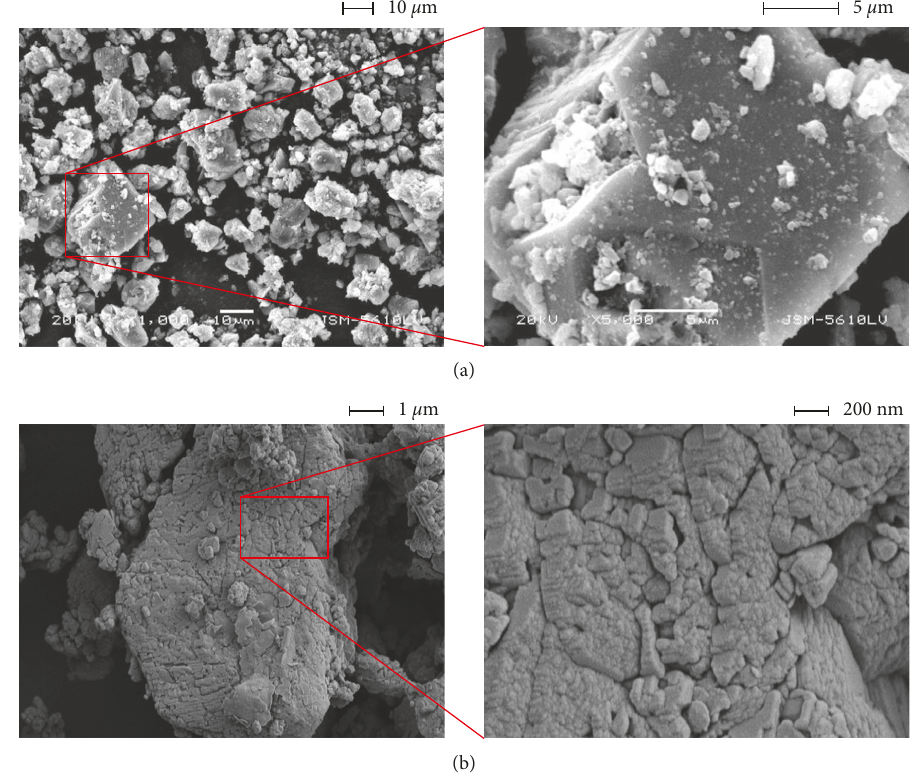
Figure 6: (a) Micron-scale particles of limestone powder. (b) Surface structure of NC/LS composite